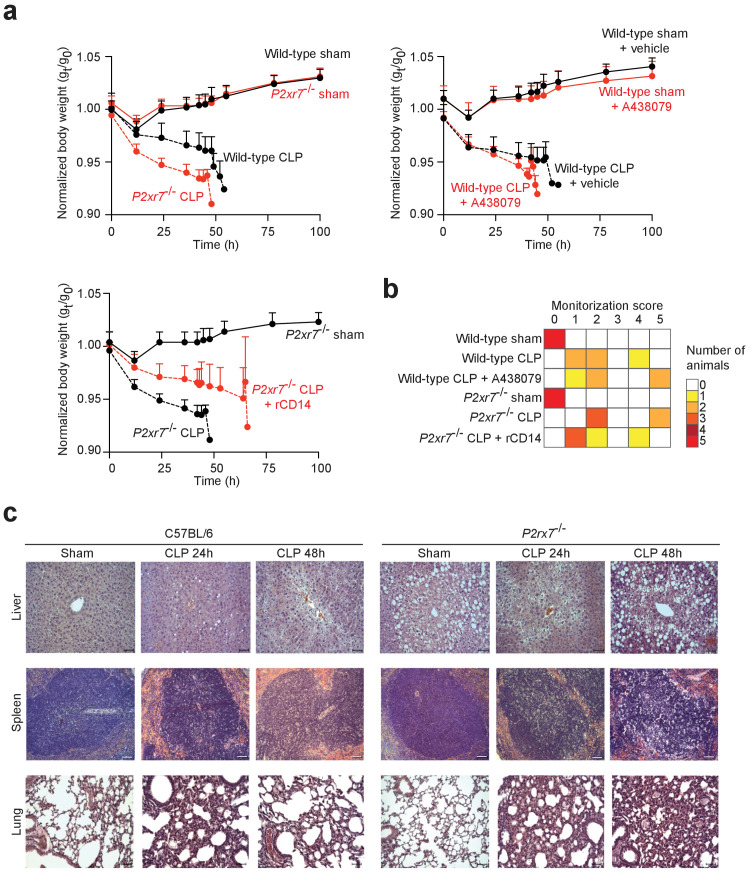
Impact of P2X7 deficiency in sepsis.(a) Normalized body weight (weight at different times/weight at the beginning, time 0: gt/g0) after sham operation or CLP for wild-type mice, wild-type treated with A438079, P2rx7−/− mice, P2rx7−/− mice with rCD14 treatment; data are represented as mean ± SEM of n = 6 animals per group, except n = 4 for the wild-type sham group treated with A438079. (b) Monitorization score of n = 5 mice per group. Animals were scored from the beginning of the study following individual values for: spiky hair, weight loss, ocular discharge, bending posture, ataxia, trembling, hypothermia, cyanosis, auto-mutilation, aggressive/comatose behavior, and stool type. When the score was between 4 and 10, the animal was supervised every hour. (c) Representative images of hematoxylin and eosin-stained liver, spleen, and lung sections from C57BL/6 (wild-type) and P2rx7−/− mice 24 and 48 hr after CLP. Scale bar 50 μm; images representative of n = 6 independent mice.